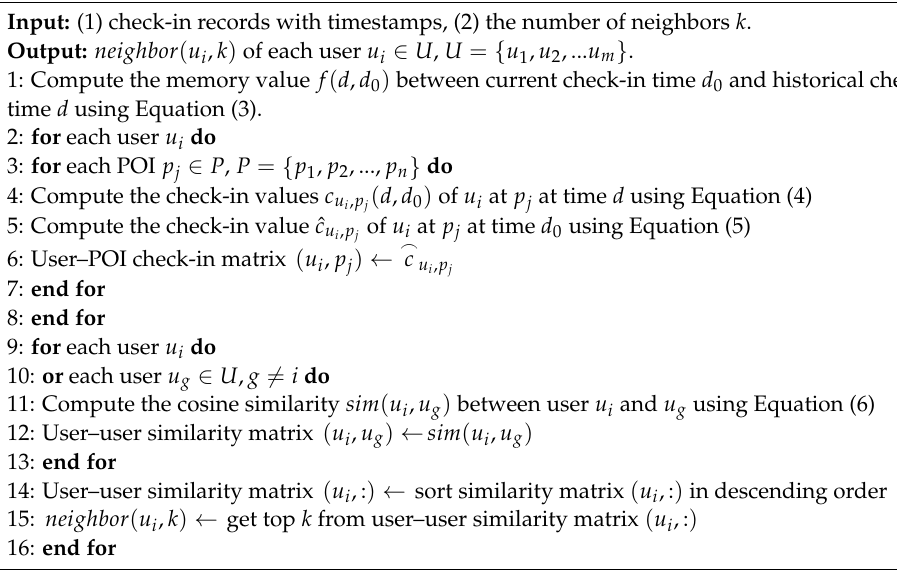
Algorithm 1. The computation of the nearest neighborhood